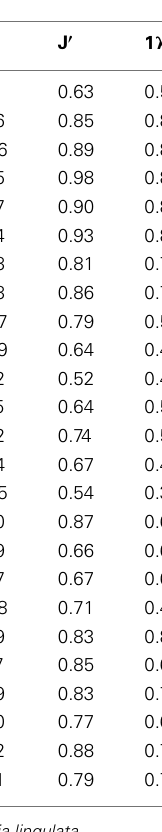
TableA2 | Bromeliads used inT-RFLP analysis, including catchment pH, plant diameter (cm), photosynthetically active radiation ( μ mol m − 2 s − 1 ) exposure at the time of sample collection, position off ground (m), group-specific abundances (%) based onT-RFLP analysis, and